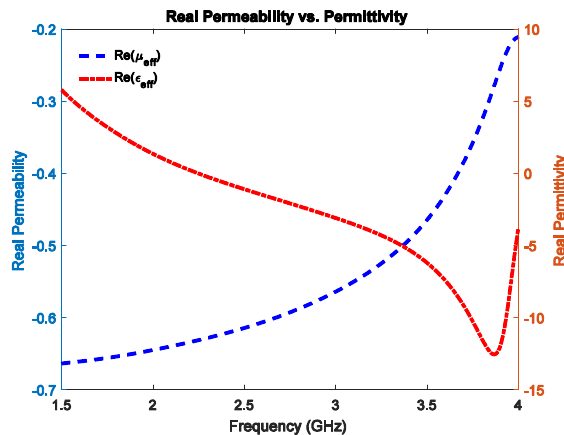
Figure 2: Real Permeability vs. Permittivity plot.